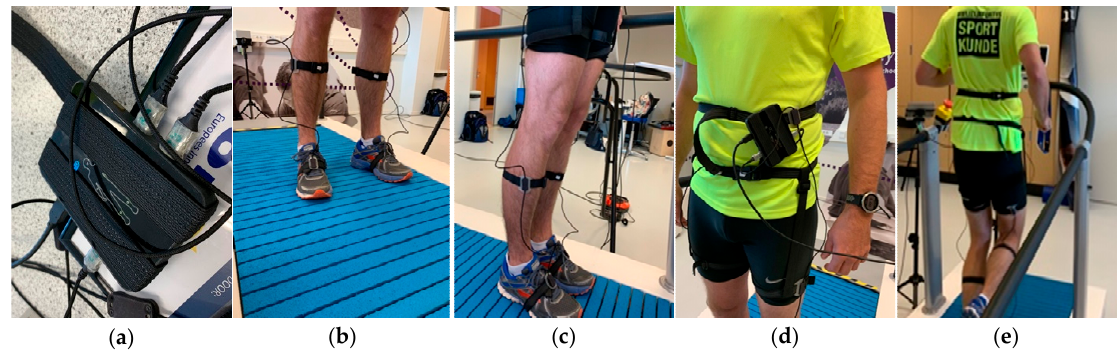
Figure 1. The Nodes sensor system with ( a ) the main unit, ( b ) the feet and shanks placed sensors and the iPad in the background, ( c ) the feet and shanks sensors from a lateral view, ( d ) the central unit attached to the runner, and ( e ) the runner during a